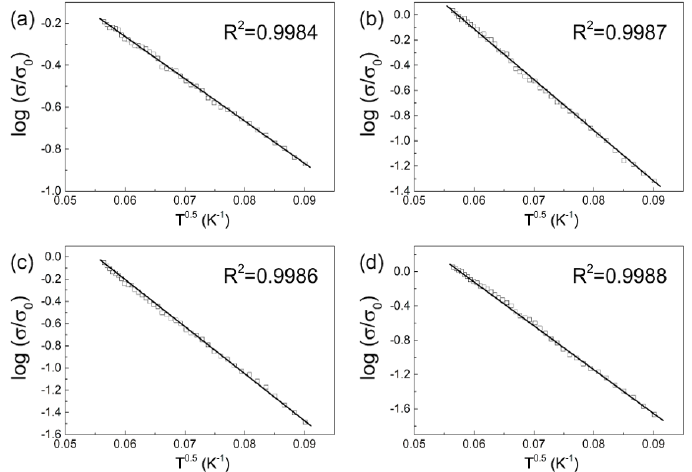
Figure 11. The fitting of experimental data by the Mott equation for neat coPA and coPA / MXene composite films: ( a ) neat coPA, ( b ) 1.0, ( c ) 2.5 and ( d ) 5 wt. % of MXene.